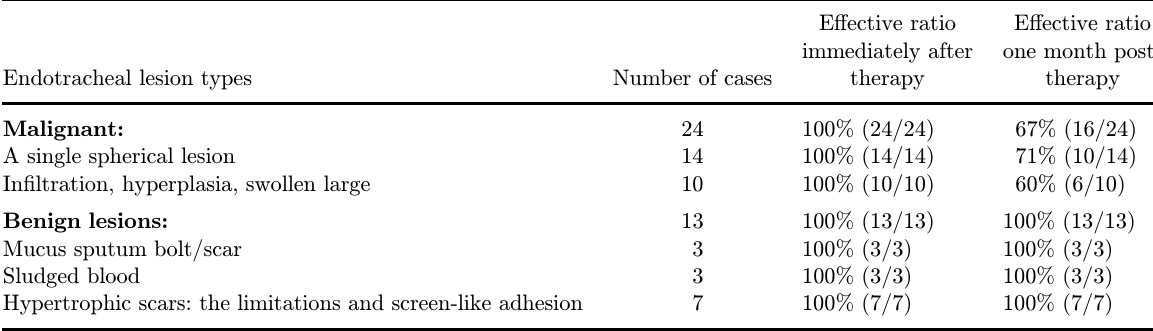
Table 2. Treated endotracheal lesion types and therapeutic